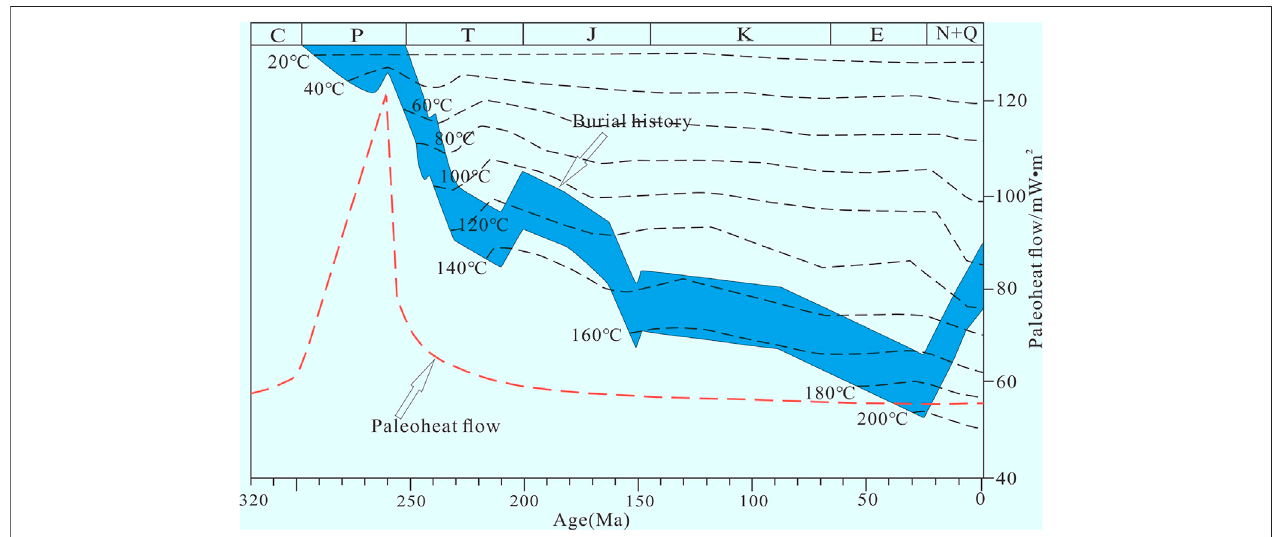
FIGURE 2 | Schematic map of burial history, paleotemperature, and paleoheat fl ow distribution of the Middle Permian (the blue part) in Well HS1 of the Western Sichuan Basin (Cai et al., 2004; Zhu et al., 2010; Wei et al., 2016; Zheng et al., 2019).